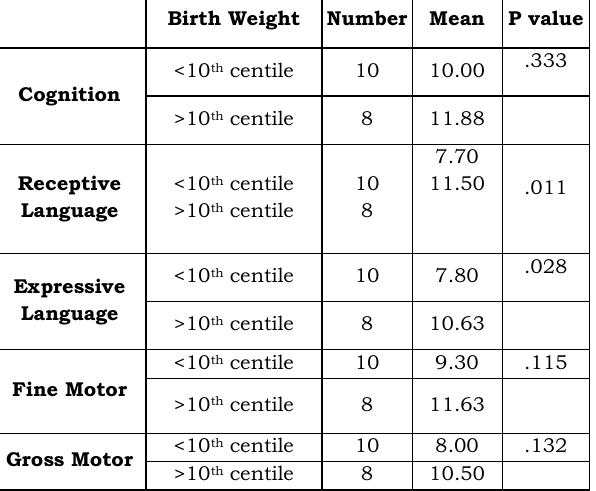
Table 5: Comparison of SGA infants with GS Birth